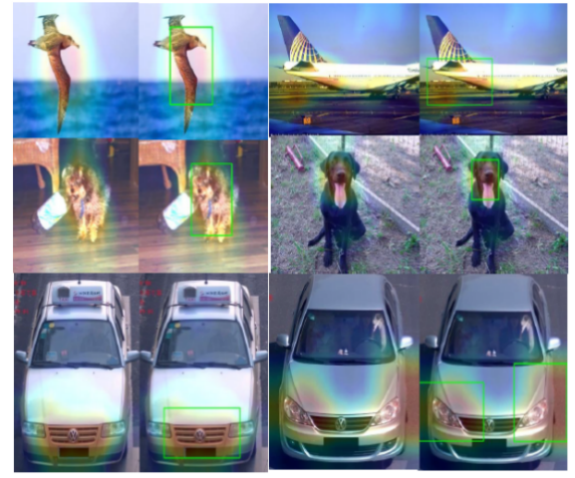
Figure 5. Saliency localization map of different images.